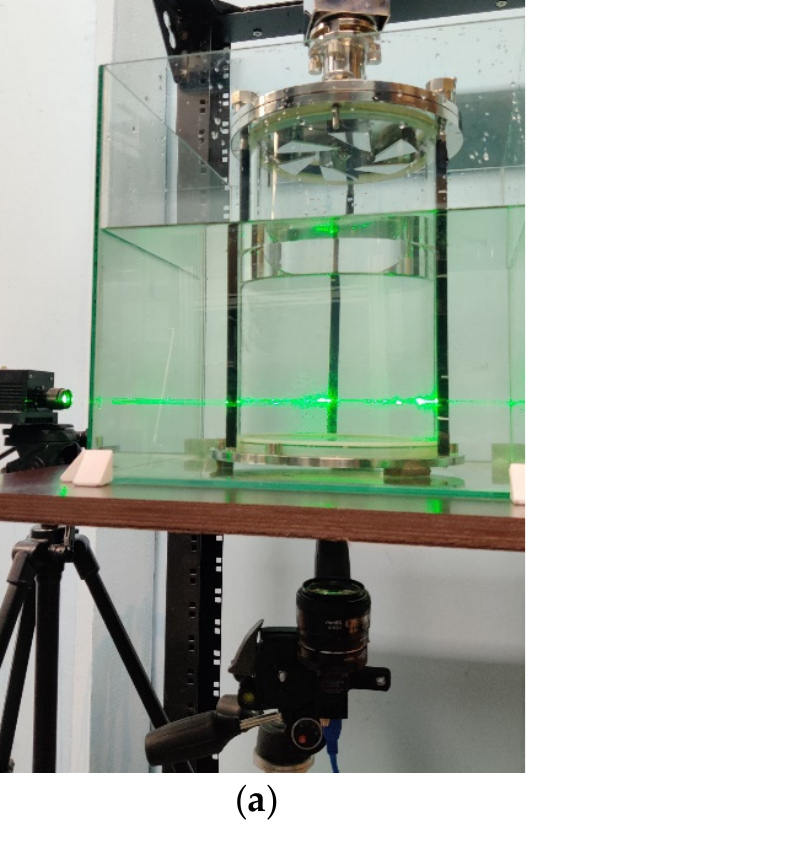
Figure 1. ( a ) A gas–liquid bioreactor: a photo of the test bench; ( b ) an impeller (activator) generating vortex motion in the bioreactor.